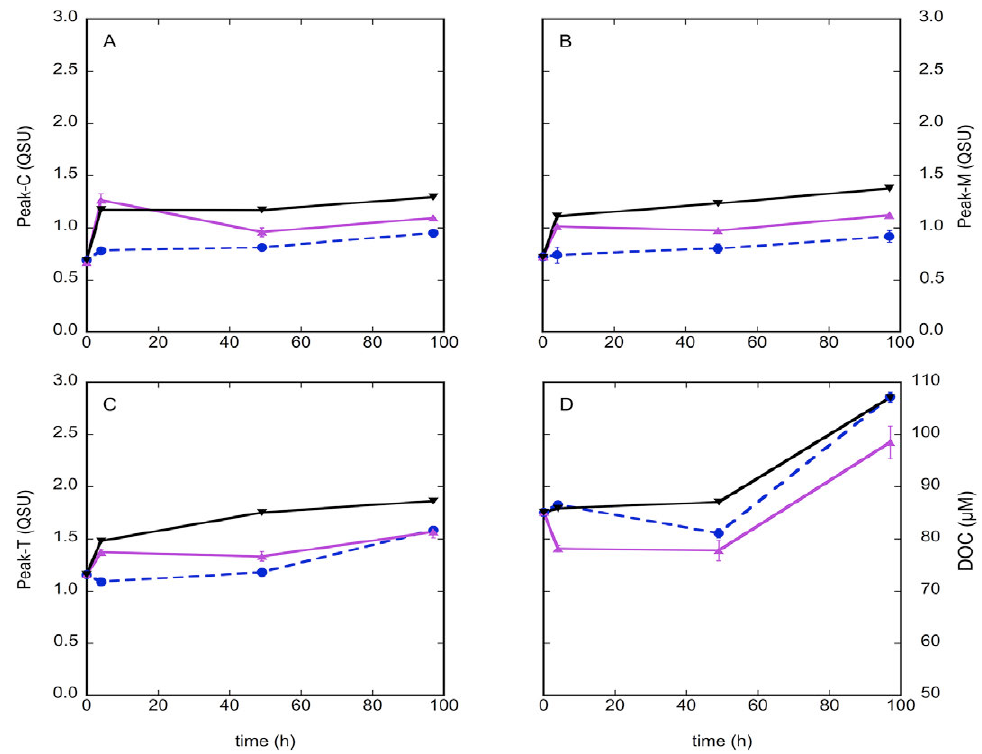
Fig. 4. – Fluorescence intensities of FDOM peaks during the course of incubation in the BCNSp experiment. (A) peak C, (B) peak M, (C) peak T and (D) dissolved organic carbon (DOC). The FDOM peaks are in quinine sulphate units (QSU) and DOC is in μM. The bars indicate the standard